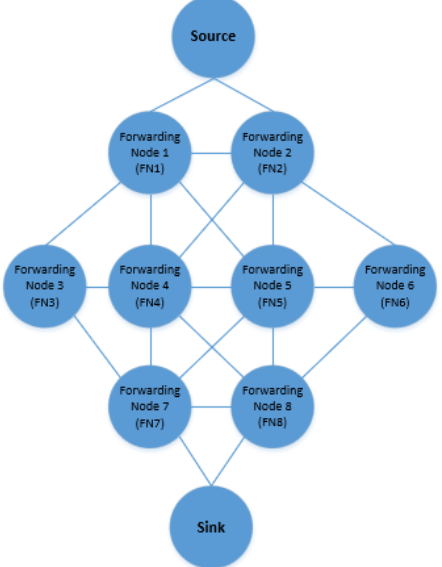
Figure 5. Scenario 3: multipath partial mesh topology with 10